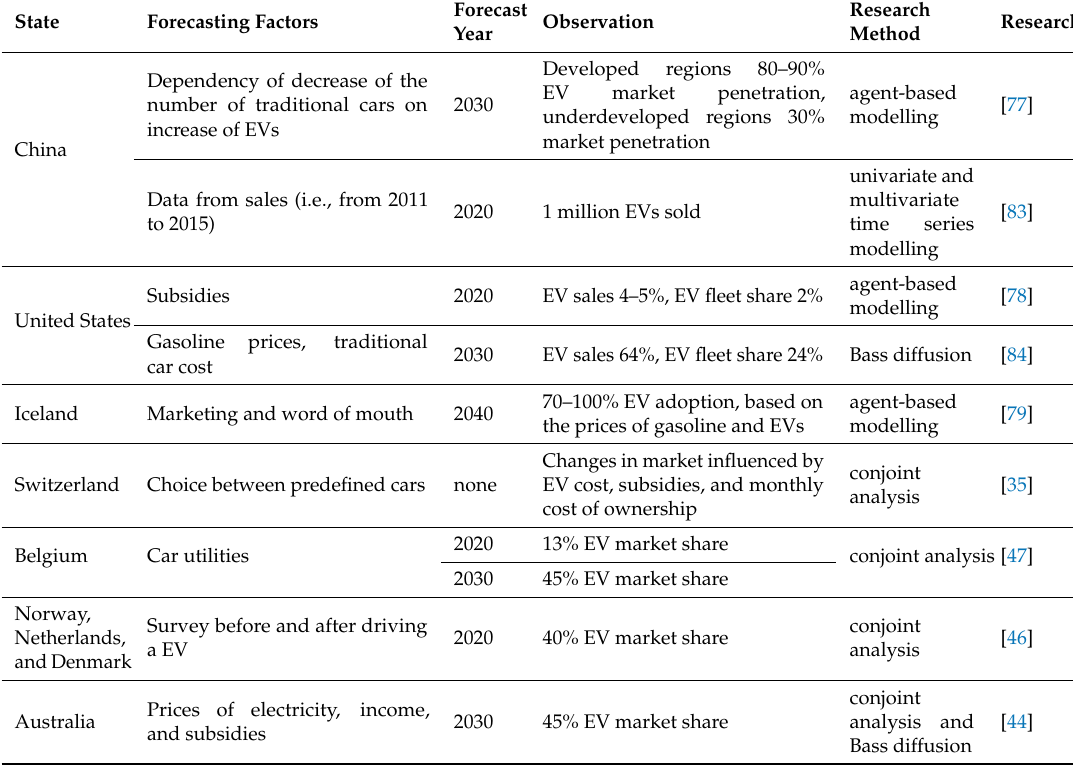
Table 3. Comparison of studies on forecasting future sales of electric vehicles